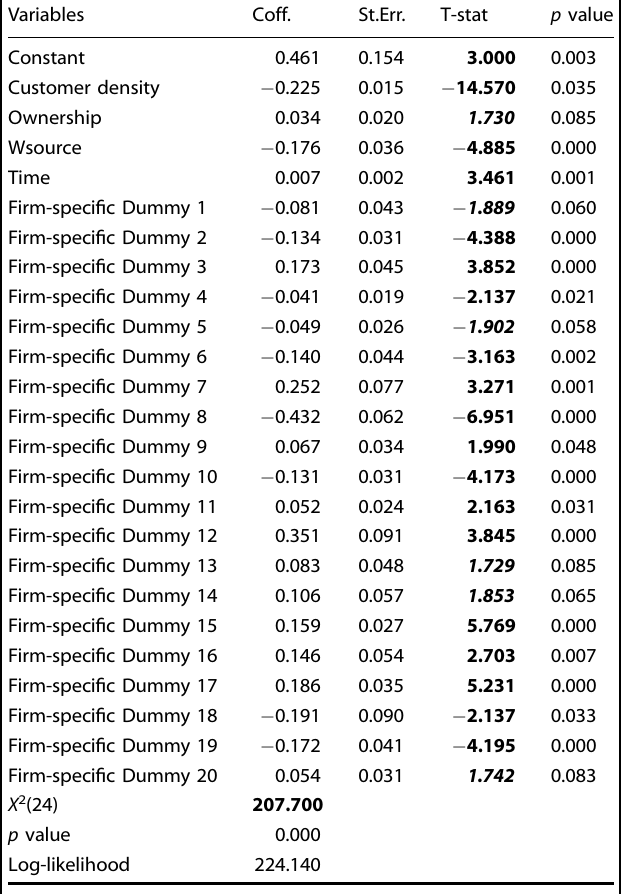
Table 2. Estimates of the Tobit